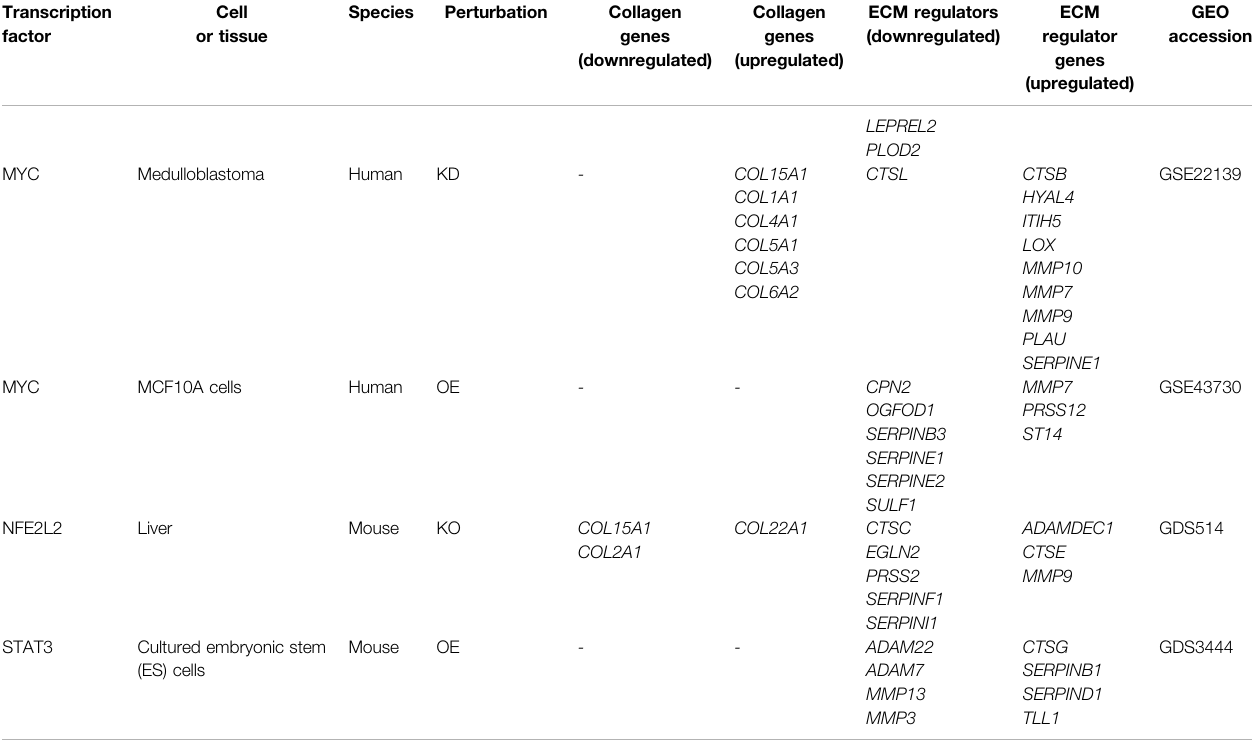
TABLE 2 | ( Continued ) List of collagen and ECM regulator genes differentially regulated after transcription factor perturbation. KD = knockdown; KO = knockout; OE = overexpression. Transcription